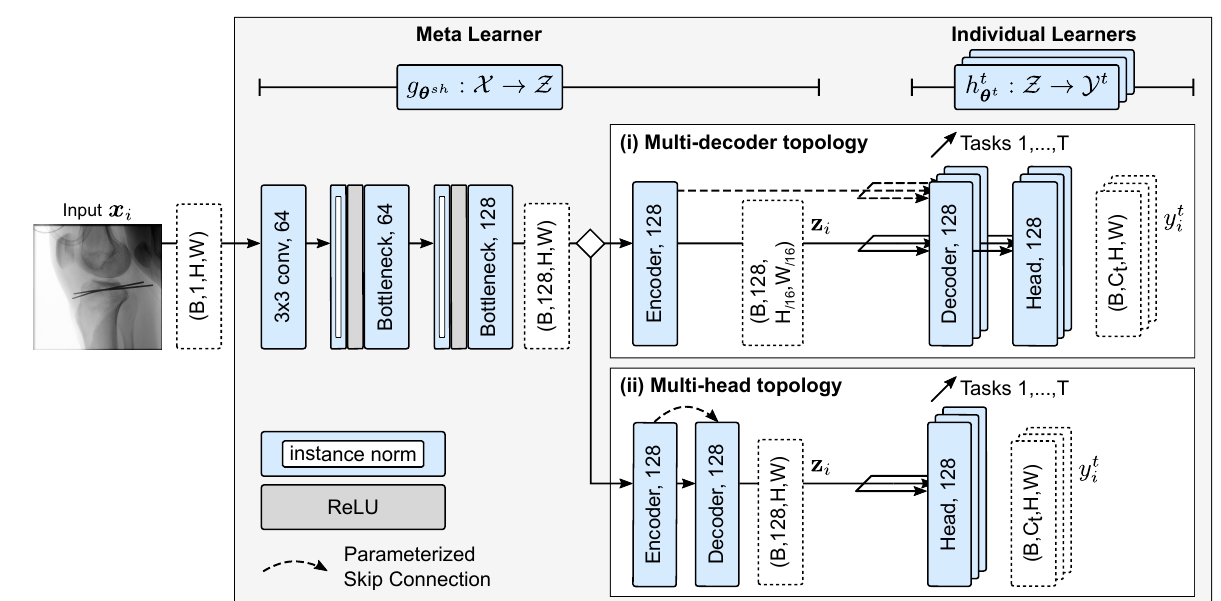
Figure 3. Architecture of the proposed multi-task network. After calculating a shared representation of the input image x i with the meta learner, an individual learner for each task computes an cor- responding prediction y T in the task solution space Y t . Two strategies for the individual learners i with different levels of parameter sharing are displayed: (i) Multi-decoder topology with indepen- dent decoders and prediction heads, (ii) Multi-head topology with shared decoder but independent prediction heads. Details of the architecture are provided in Figure A3, Table